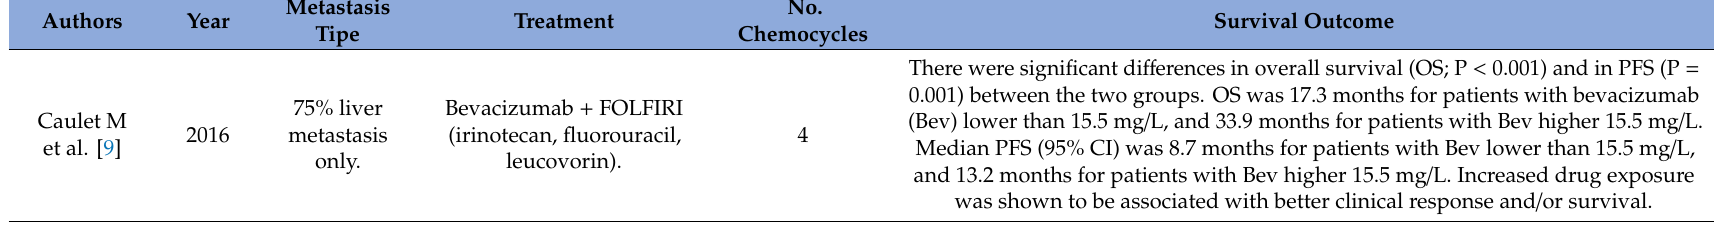
Table 2. Study summary